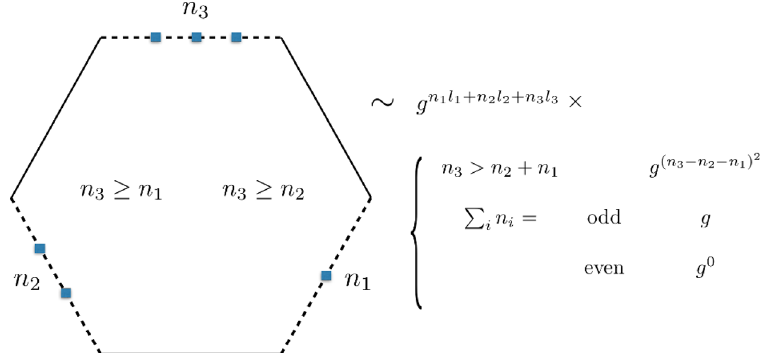
Figure 1 . This (cid:12)gure (cid:12)rstly appeared in [39] and it is also discussed in [43]. The solid lines correspond to physical edges of the hexagon form-factor and the dashed lines to mirror edges. The rule appearing in the (cid:12)gure enables one to estimative at each order in the coupling constant g a con(cid:12)guration of mirror particles involving various hexagon form-factors kicks in. One only has to multiply the g factor obtained as in the (cid:12)gure for all the hexagons of a graph. Each excitation showed in the (cid:12)gure is properly normalized, i.e. it carries a square-root of the measure not explicitly indicated. The rule in the (cid:12)gure can be derived by using the decoupling property of the hexagon form-factors and the g dependence of its dynamical part, see [33]. The numbers n i ’s indicate the number of mirror particles (elementary or bound-states) in each mirror edge. The n 3 is selected among the others by the constraints n 3 n 1 and n 3 n 2 . The l i indicates the bridge lengths of (cid:21) (cid:21) each mirror